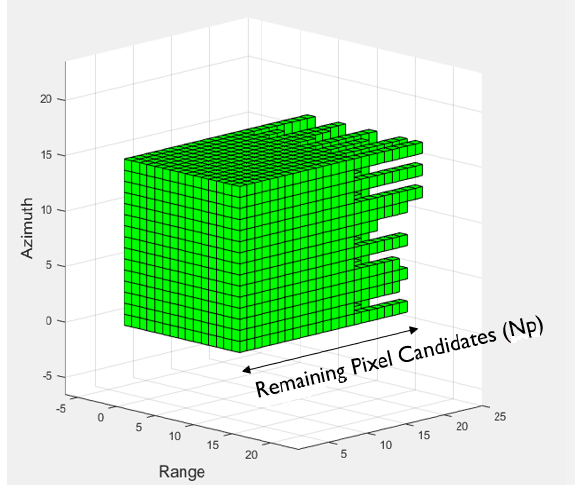
Figure 4. Inhomogenous dimensions in time direction of candidate